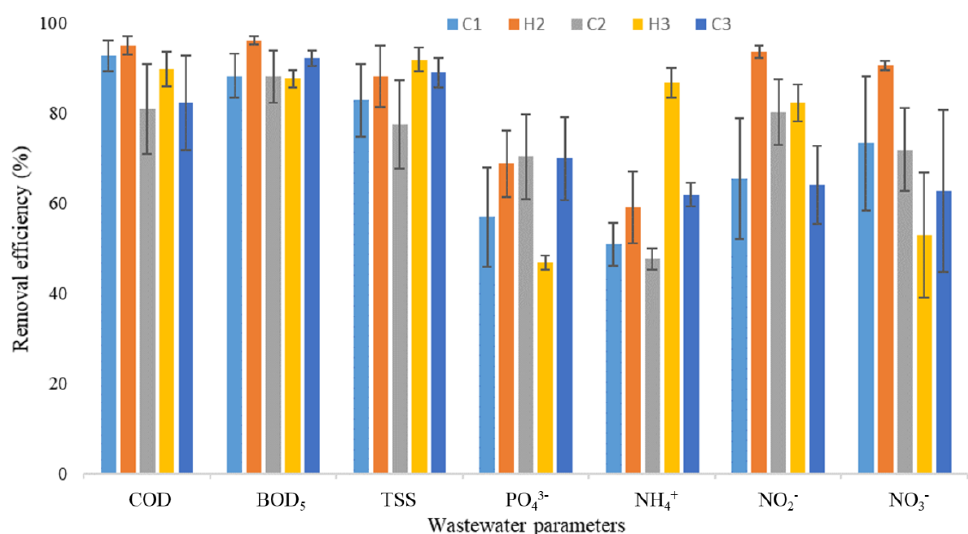
Figure 2. Removal efficiency of the CW wastewater parameters for each sampling trial, during cold (C) and hot (H) seasons across three consecutive years (1, 2, 3).